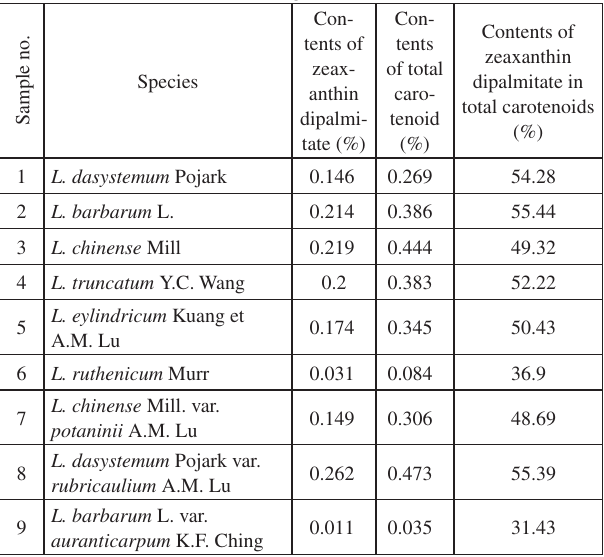
Table 2. Contents of zeaxanthin dipalmitate and total carotenoid in Fructus Lycii from different species of the genus Lycium in China (Source: Yong et. al., 2005.)